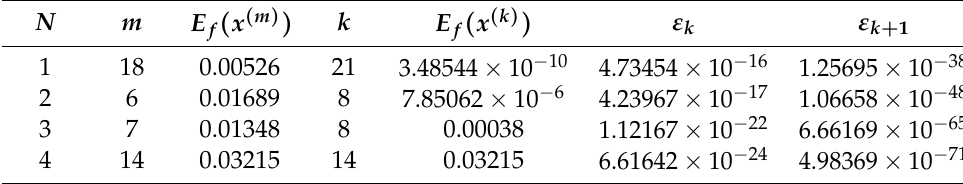
Table 4. Convergence behavior for Example 2 ( R n = 0.125, τ n = 0.171573). N